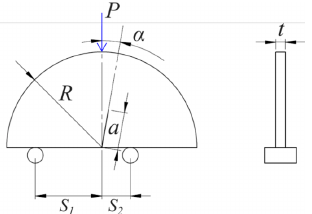
Figure 1. Geometrical parameters and loading conditions of the IASCB (Inclined edge cracked Semi-Circular Bend) specimen.